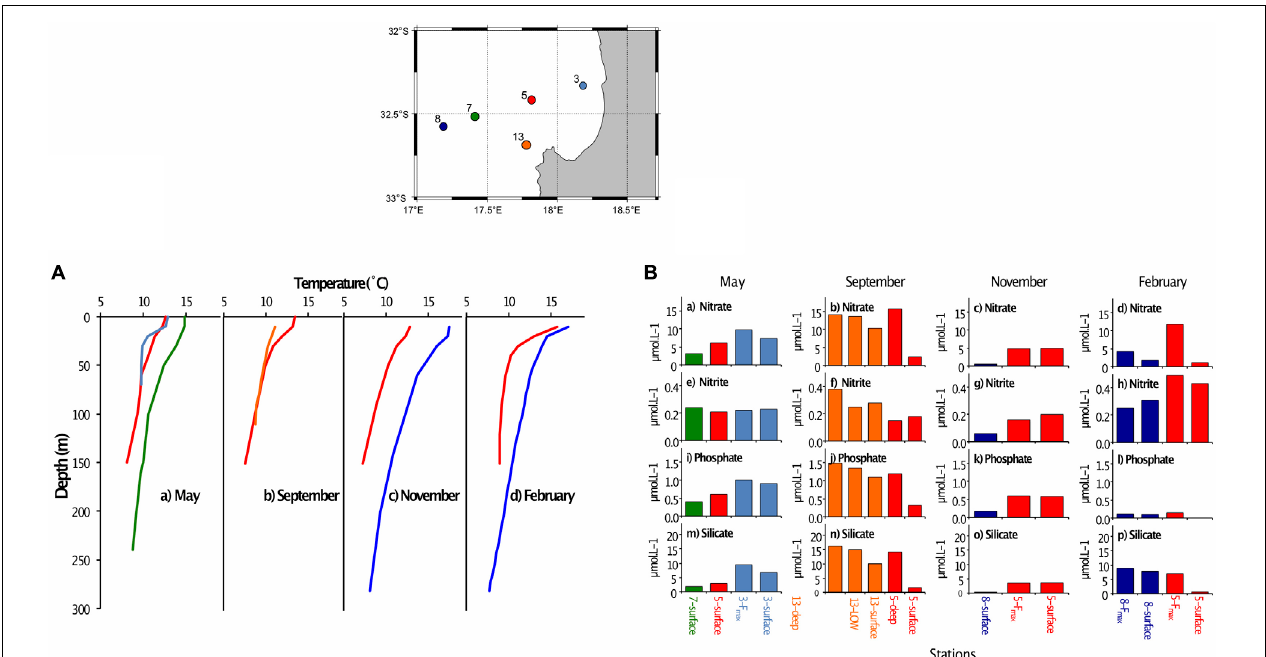
FIGURE 2 | (A) Vertical profiles showing temperature at depth for stations sampled along the St Helena Bay Monitoring Line in (a) May 2015, (b) September 2015, (c) November 2015 and (d) February 2016. The five stations (insert) are color-coded as follows: 3 – light blue, 5 – red, 7 – green, 8 – dark blue, 13 – orange. (B) Nutrient concentrations ( µ mol.L − 1 ) at stations sampled along the St Helena Bay Monitoring Line in May 2016, September 2016, November 2016 and February 2017 at the surface, the fluorescence maximum (F max ) and near the bottom (deep). (a–d) nitrate, (e–h) nitrite, (i–l) phosphate, (m–p) silicate. The five stations (insert) are color-coded as follows: 3 – light blue, 5 – red, 7 – green, 8 – dark blue, 13 –